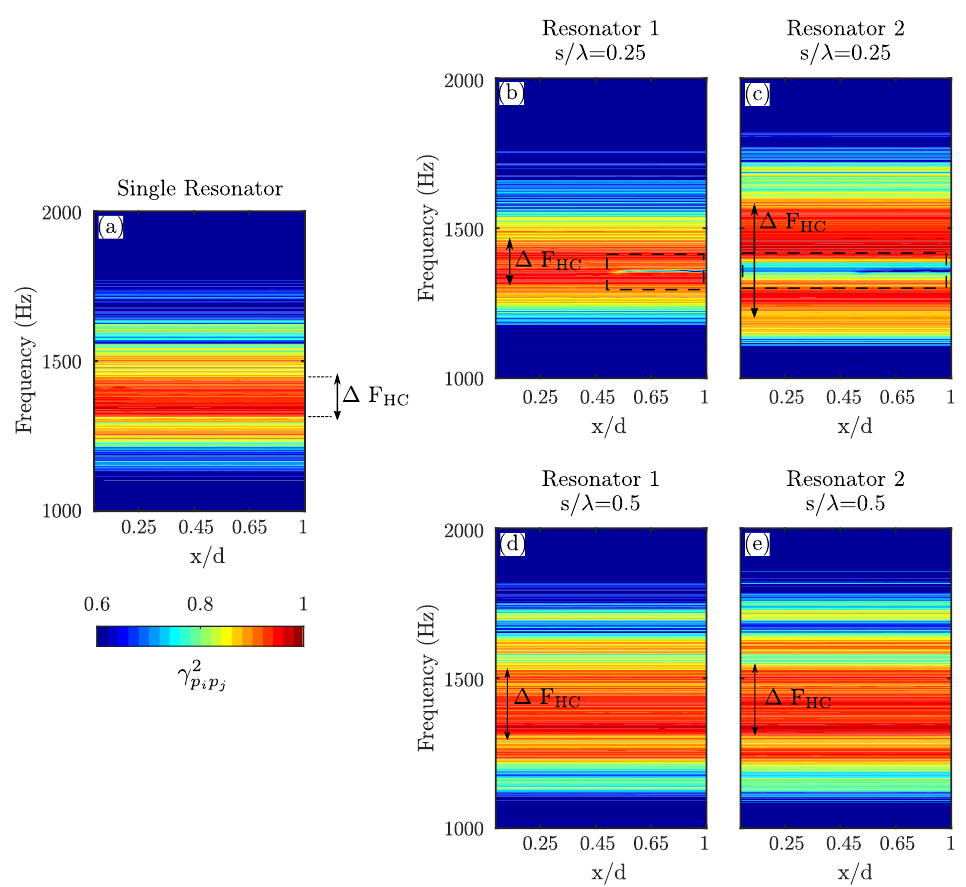
Figure 12. Magnitude squared coherence of acoustic signal from microphone M1 and M2 with micro- phones G1 to G20. ( a ) Single Resonator; ( b ) s / λ = 0.25 (Resonator 1); ( c ) s / λ = 0.25 (Resonator 2); ( d ) s / λ = 0.5 (Resonator 1); ( e ) s / λ = 0.5 (Resonator